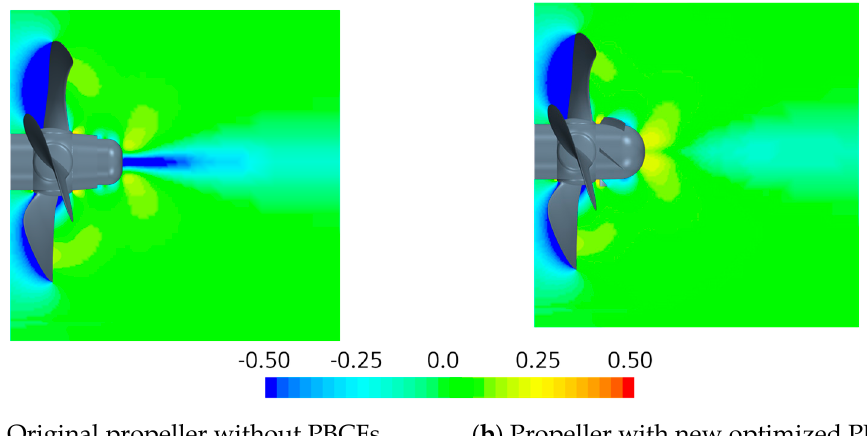
Figure 10. Pressure coefficient C p contour around the propeller without the rudder: ( a ) original propeller, ( b ) propeller with optimized PBCFs.